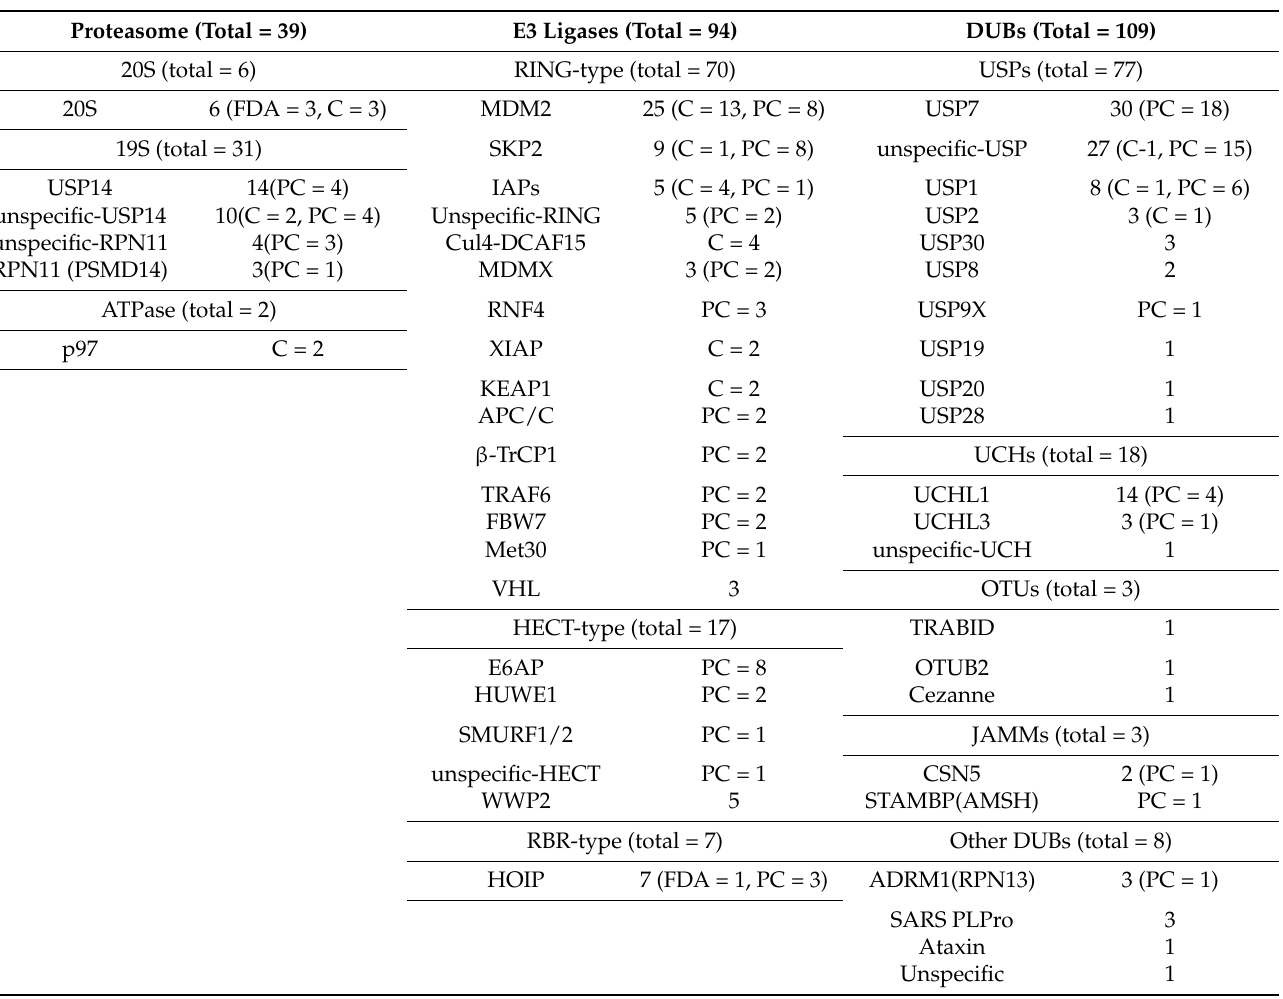
Table 1. Summary of the existing small molecules targeting the proteasome, E3 ligases, and DUBs. The total number of small molecules per family of enzymes as well as for each individual enzyme and subunits of the proteasome are listed. Annotations are made to quantify number of compounds on preclinical (PC) and clinical testing (C) or FDA approved. Due to the vast diversity of E3 and DUBs the list is updated and comprehensive, listing almost 250 compounds, but it is possible that it is not complete. The small molecules include small molecule inhibitors targeting the catalytic enzymatic domain, as well as those acting as antagonist or blockers of protein–protein interactions, based on published articles [16,242–248], and public